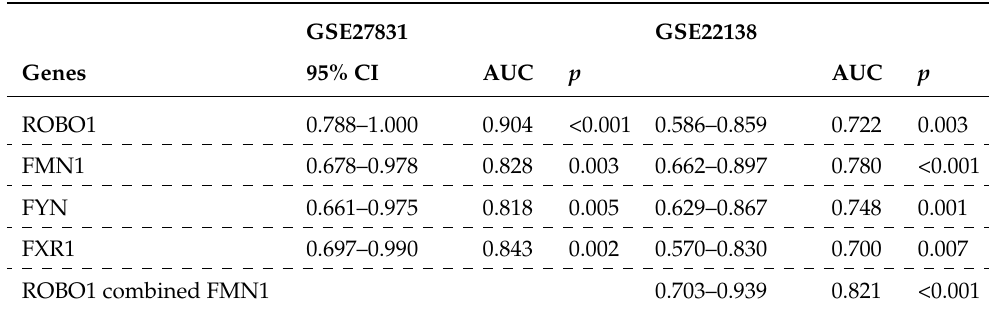
Table 3. Individual area under the receiver-operating characteristic curve (AUC) and p values of hub genes to predict metastasis.